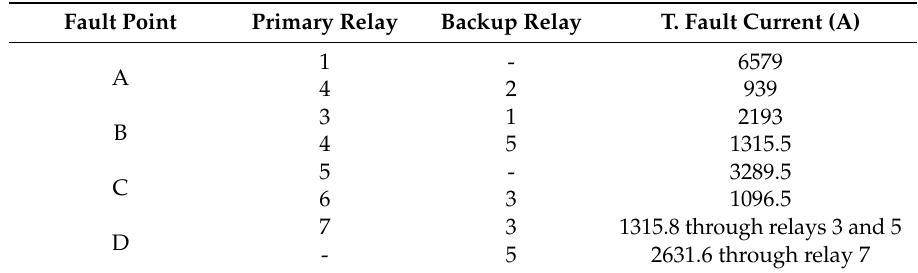
Table 10. Primary and backup relationships of the relays and maximum fault current for Case 3. Fault Point